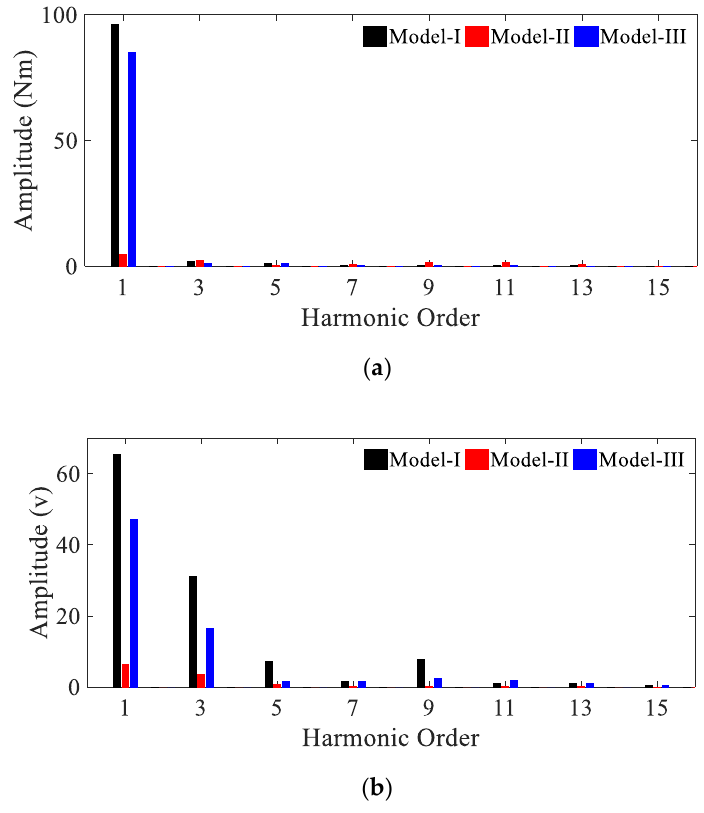
Figure 19. Optimized models: ( a ) Phase Back-EMF, ( b ) Back-EMF